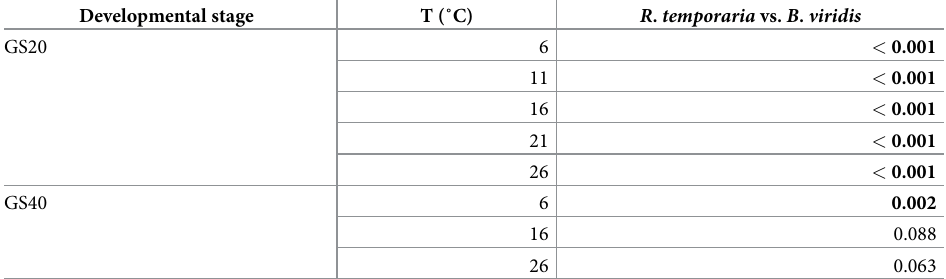
Table 3. Comparison of Folpan 1 500 SC 48h-LC 50 values between species. Significant differences after Bonfer- roni-correction are presented in